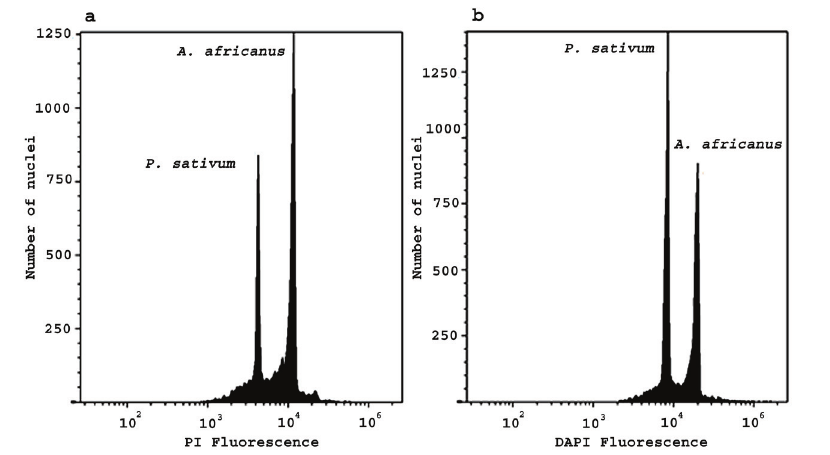
Figure 2 - Flow cytometry histograms representing Agapanthus africanus (L.) Hoffmanns using Pisum sativum L. (9.09 pg) as internal standard. (a) The fluorochrome propidium iodide (PI) was used to measurement of DNA amount (24.4 pg; CV=2.47) (2C values). (b) The fluorochrome 4′,6-diamidino-2-phenylindole (DAPI) was used to determine the AT base percentual (59%; CV =